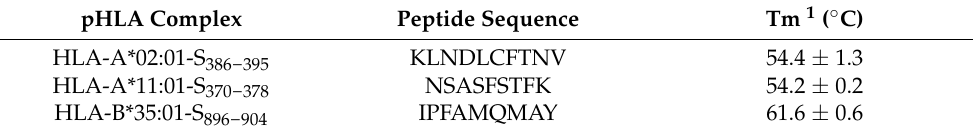
Table 1. Stability of pHLA